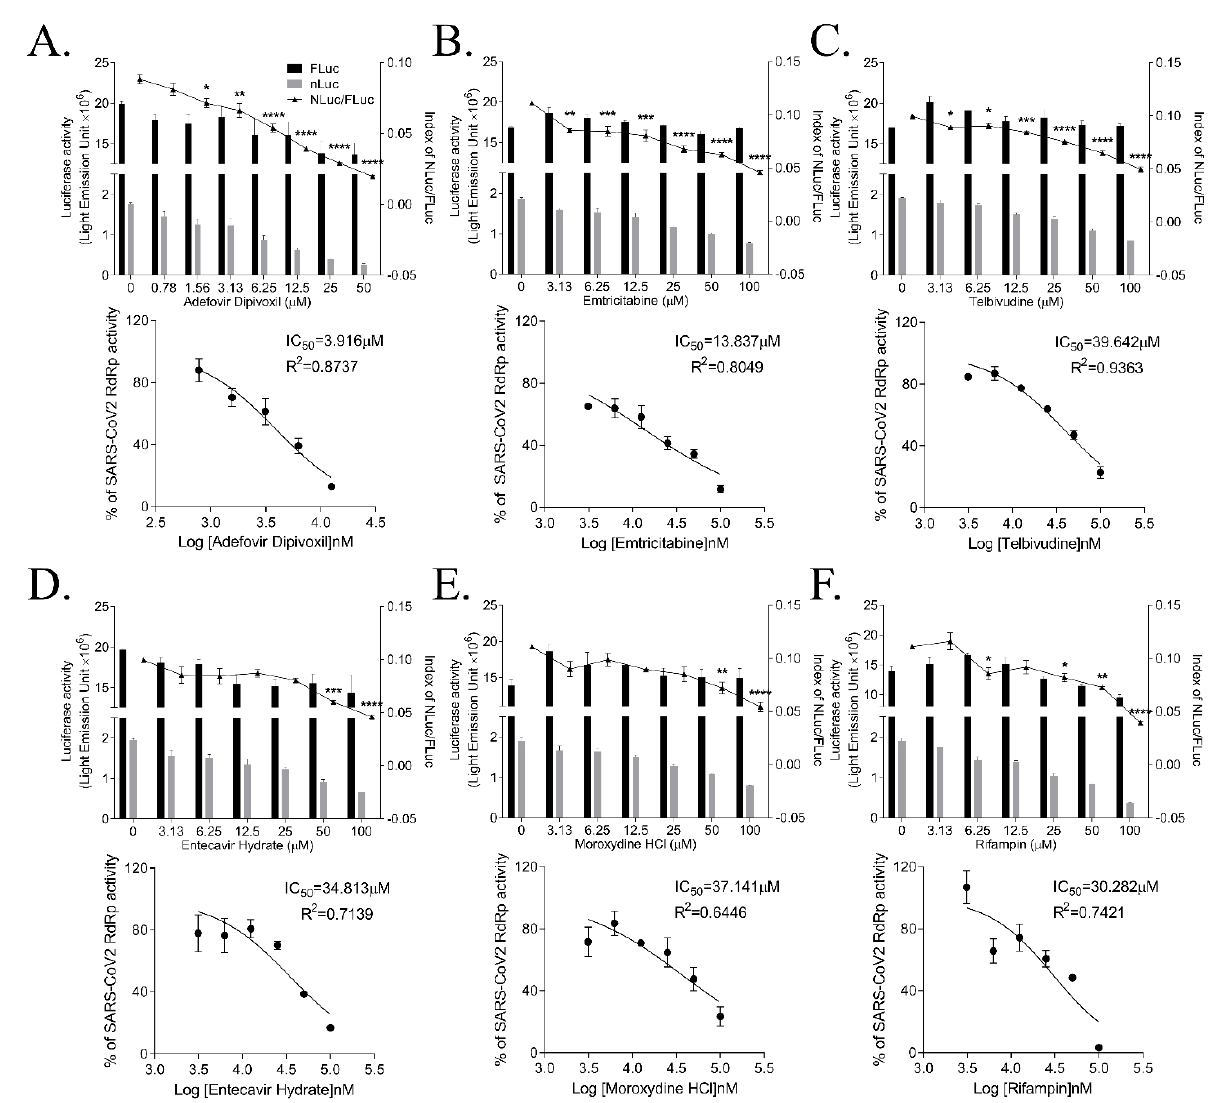
Figure 5. Effect of nucleoside and nucleotide analogs on SARS-CoV-2 RdRp activity. HEK293T cells were transfected with p(+)FLuc-( − )UTR-NLuc and pCI-SARS2-nsp12N. After 6 h, the cells were treated with serially diluted-adefovird dipivoxil ( A ), emtricitabine ( B ), telbivudine ( C ), entecavir hydrate ( D ), moroxydine HCl ( E ), or rifampin ( F ) for 15 h. FLuc and NLuc activities were measured to determine the NLuc/FLuc ratios. Statistical comparisons were conducted using one-way analysis of variance (ANOVA) followed by Bonferroni’s multiple comparison test. * p < 0.05; ** p < 0.01; *** p < 0.001; **** p < 0.0001 vs. 0 µ M (upper graph). The IC 50 values were calculated using non-linear regression analysis (lower graph). The data were representative of at least three independent experiments and presented as mean ± standard error of the